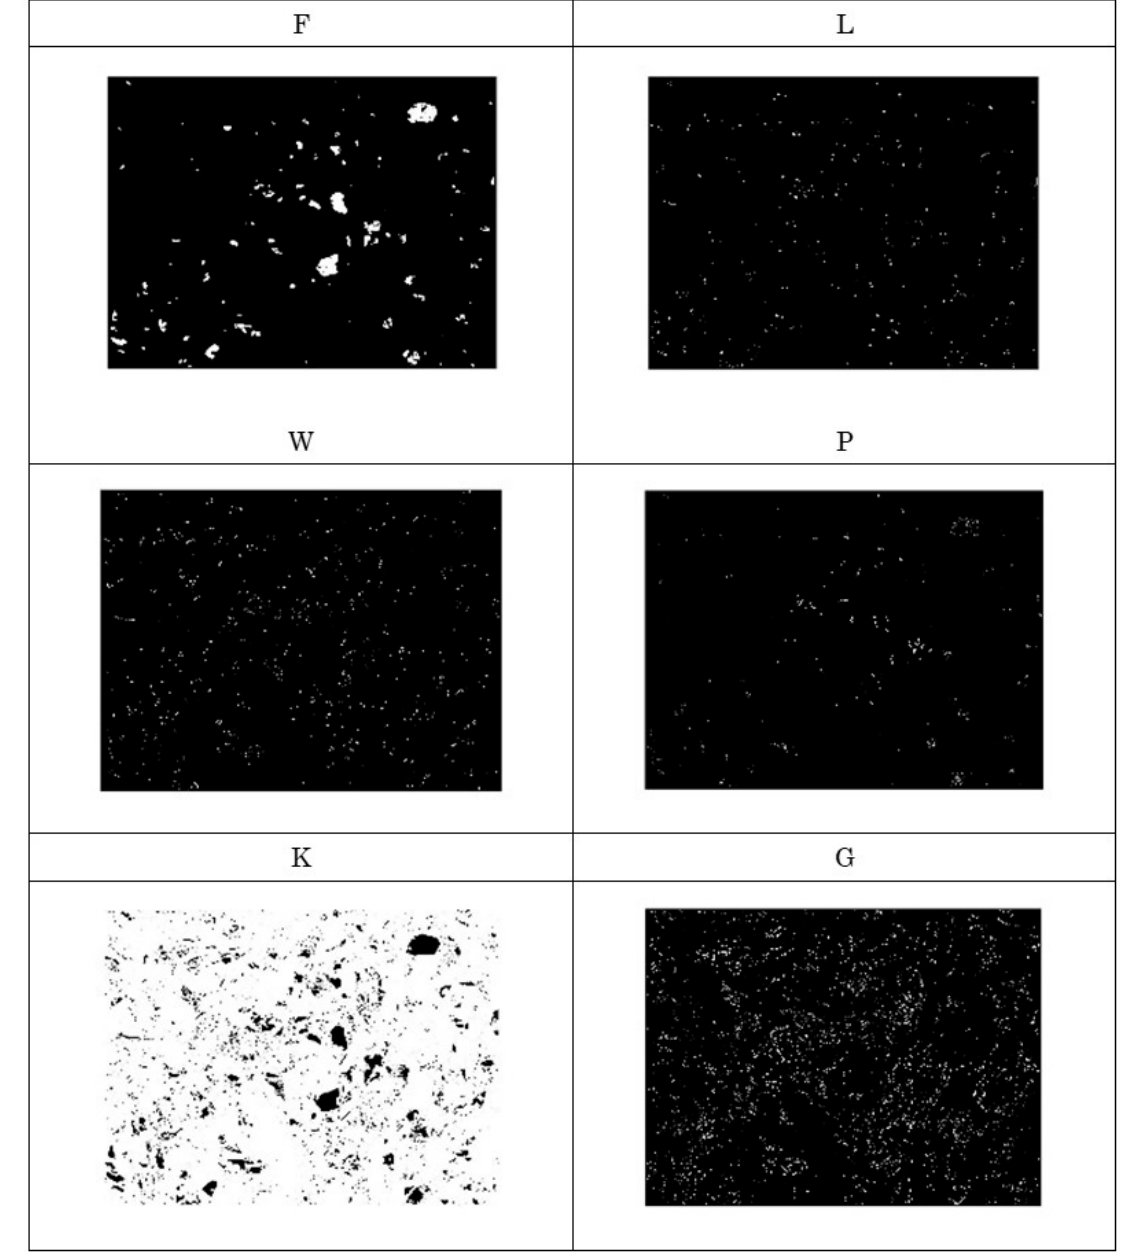
Figure 9. Existence of amino acids denoted as F, L, W, P, K, and G in Prot k,l based on the ACGT